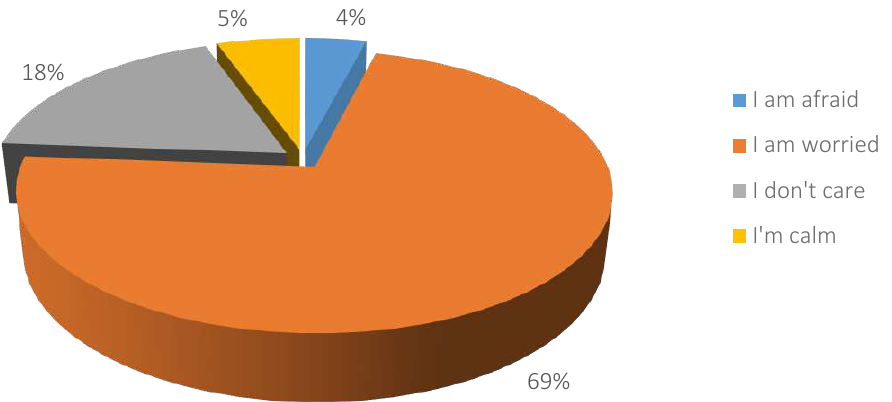
Figure 8. Impact of coronavirus news on